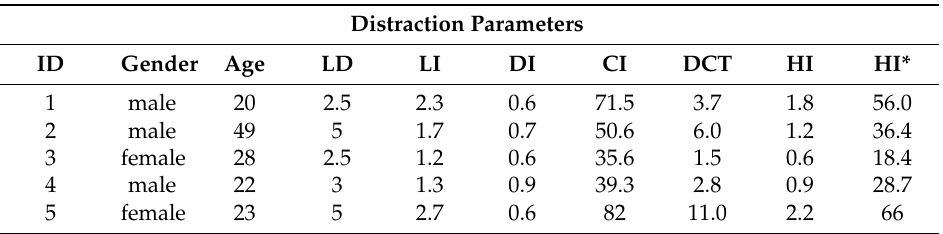
Table 3. Patient list with distraction parameters. LD: lengthening distance in cm; LI: lengthening index; DI: distraction index; CI: consolidation index; DCT: distraction-consolidation time; HI: healing index; HI*: modified healing